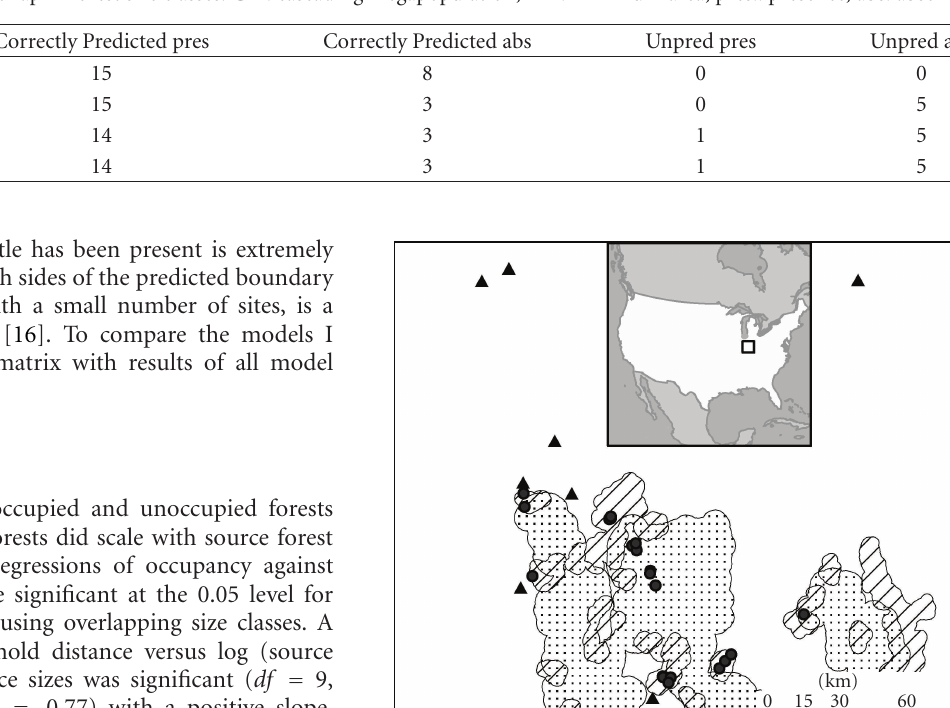
Table 1: Confusion matrix for cascading megapopulation with overlapping size ranges and alternative models for geographical range of G. speciosus . Overlap refers to overlap in forest size classes. CM: cascading megapopulation; MA: minimum area; pres.: presence; abs: absence.